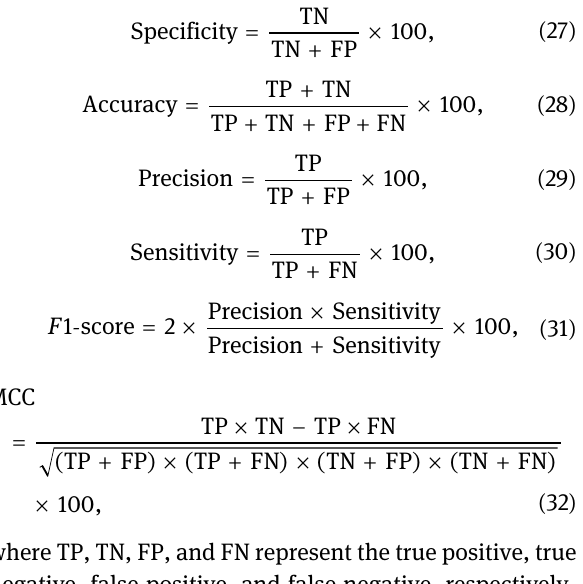
where N de fi nes the number of training samples, d and y